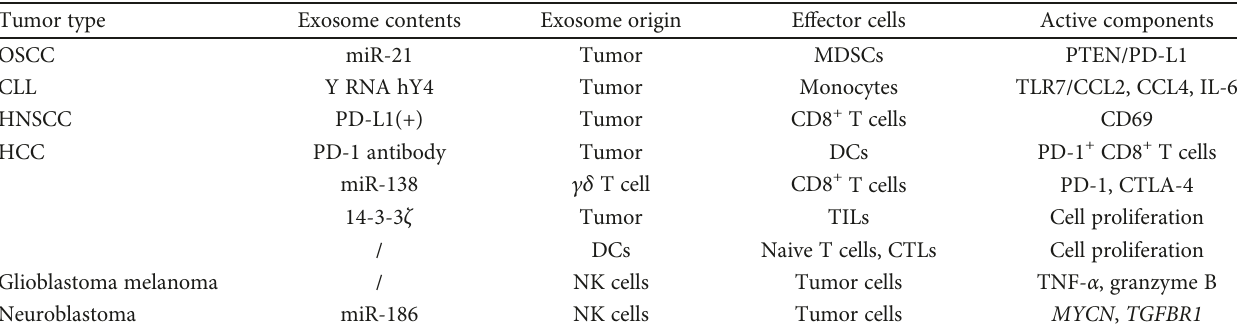
Table 3: Exosomes and